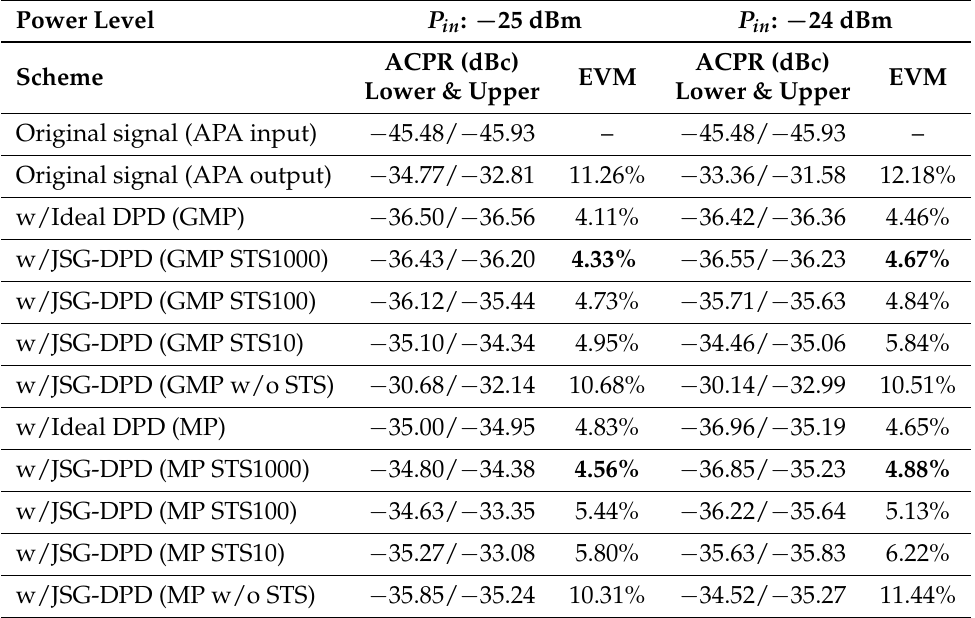
Table 1. Measured ACPR and EVM results with different methods for different input power levels from